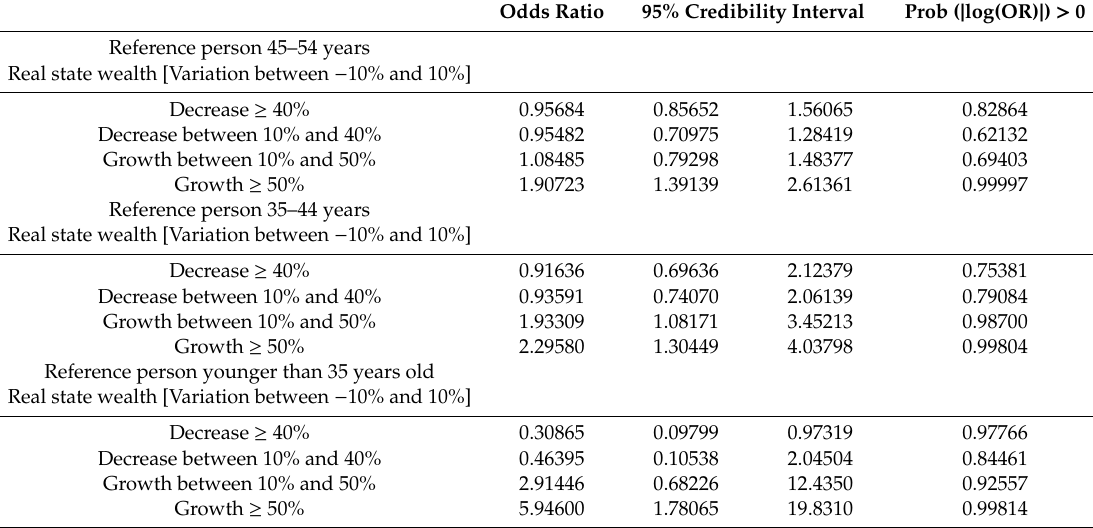
Association between the variation in real estate wealth and good and very good self-perceived